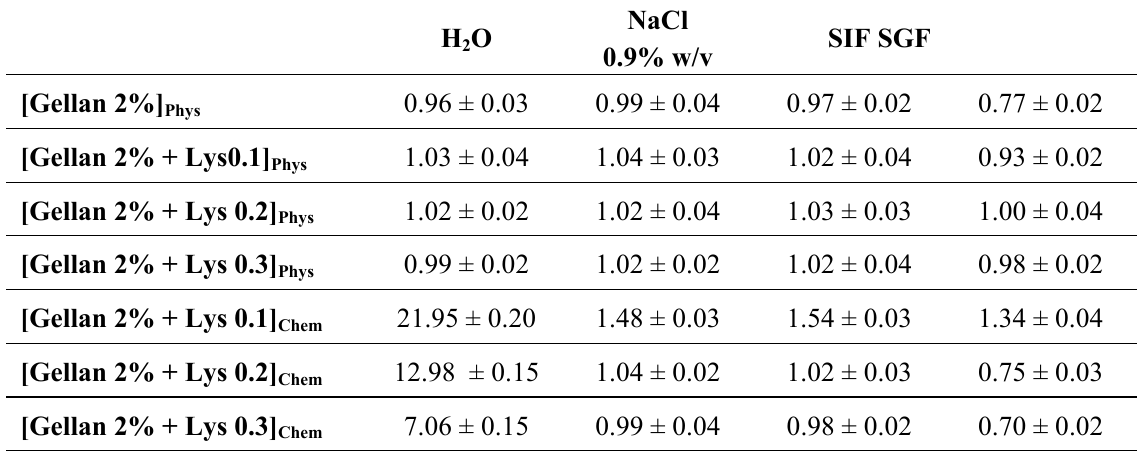
NaCl H O SIF SGF 2 0.9% w/v 0.96 ± 0.03